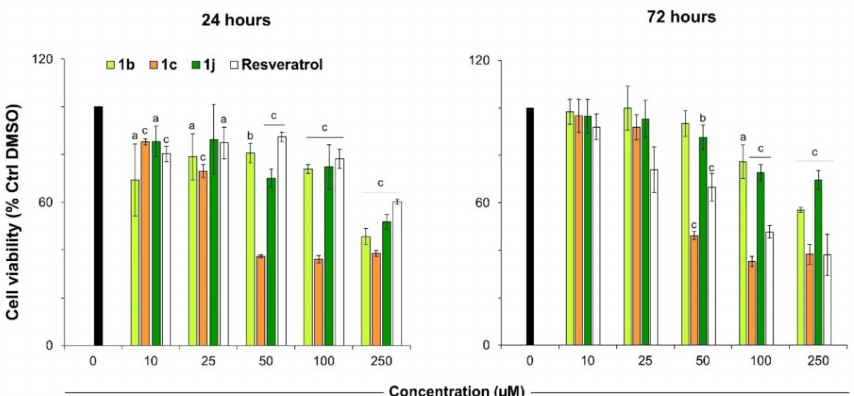
Figure 6. Cell metabolic activity of MCF7 human breast cancer cells in the presence of increasing concentrations of compounds 1b , 1c , 1j , and RSV . Data shown are the means ± S.D. of three replicates and are expressed as percentages of cultures in the presence of vehicle (DMSO) set as 100%. a = p < 0.01; b = p < 0.001; c = p < 0.0001 between compounds and